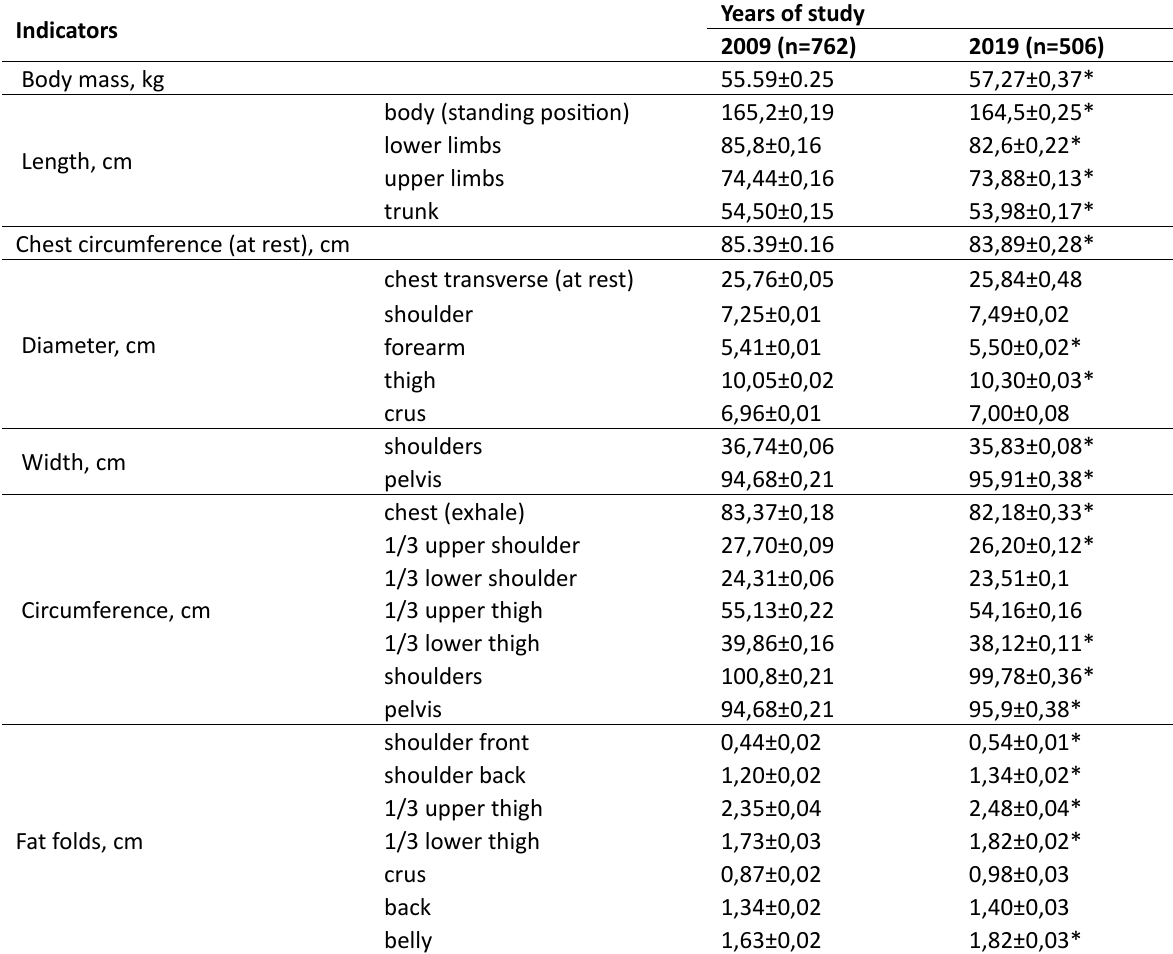
Table 1. The anatomical characteristics of 17-20 years old different populations females (M ± m) Indicators